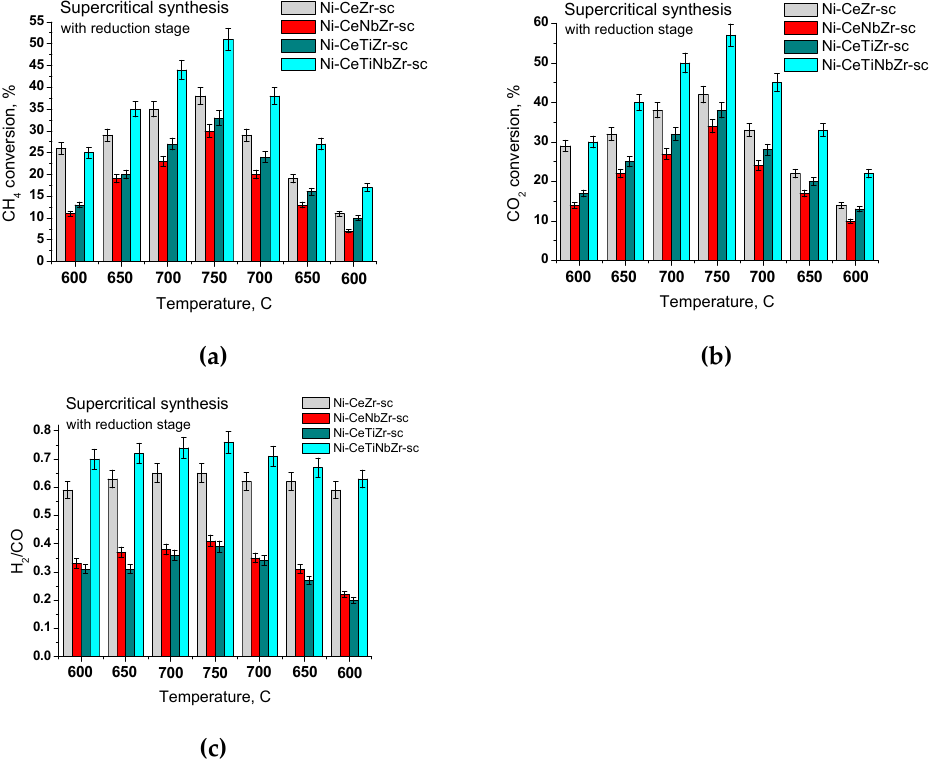
Figure 13. Steady-state conversions ( a , b ) and syngas compositions ( c ) at different temperatures over catalysts prepared in supercritical conditions, with preliminary reduction stage.